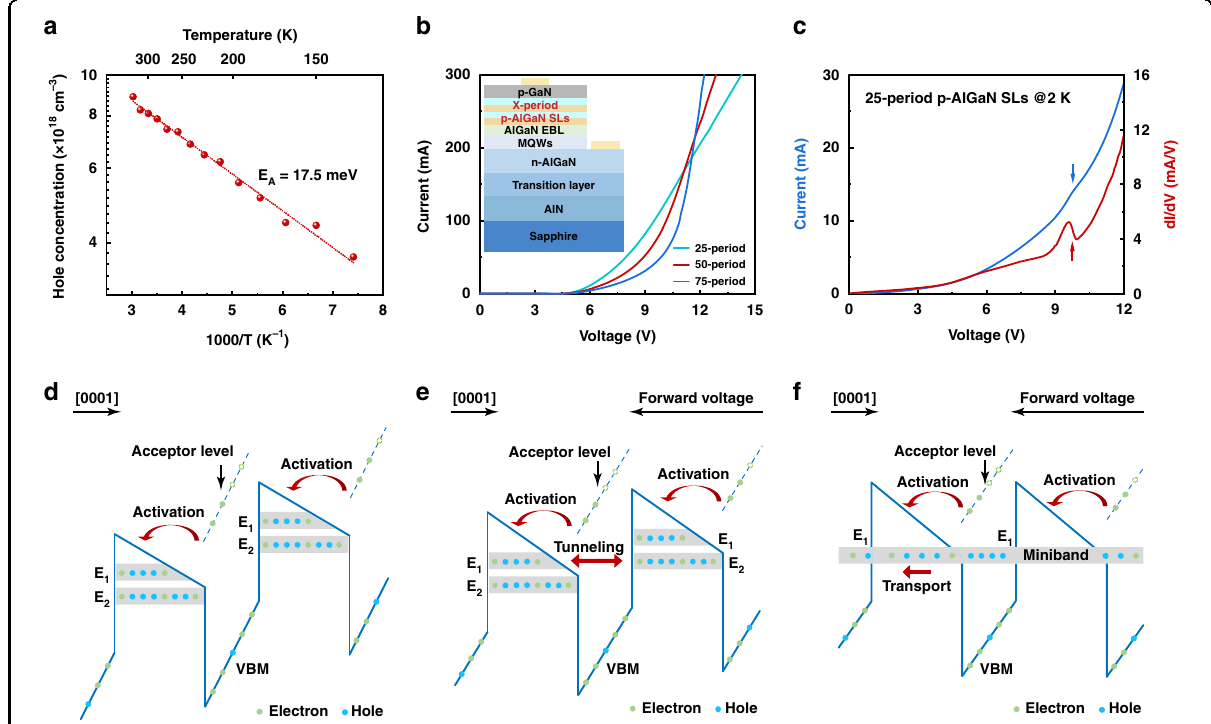
Fig. 3 Electrical properties of the desorption-tailored Al-rich p-AlGaN SLs. a Temperature dependence of the hole concentration in the desorption-tailored p-AlGaN SLs. b I – V curves at room temperature of DUV-LED structures (inset) with p-AlGaN SLs period of 25, 50, and 75, respectively. c I – V and corresponding dI/dV curves at 2 K of DUV-LED structure with 25-period p-AlGaN SLs. d The upward inclining of the p-AlGaN SLs energy band pro fi le along [0001] direction at equilibrium. e Resonant tunneling between E 1 and adjacent E 2 when fl attening the p-AlGaN SLs energy band pro fi le along [0001] direction by applying a forward voltage. f Formation of minibands when applying a higher forward